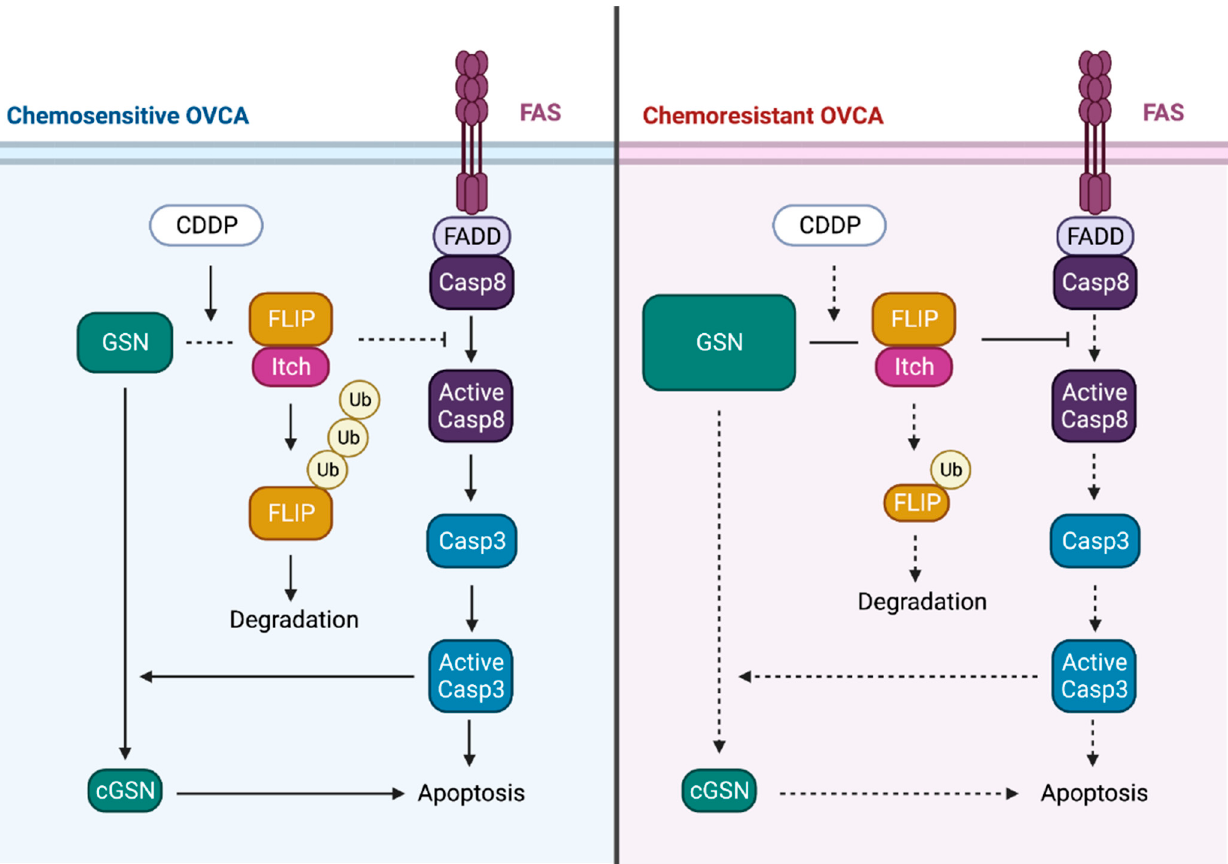
Figure 3. Apoptosis Regulation by pGSN. FLIP and ITCH form a complex with GSN in the chemosensitive OVCA cell. CDDP dissociates GSN from the GSN-FLIP-ITCH complex, leading to FLIP ubiquitination and degradation, caspase-8 and -3 activation, caspase-3-mediated GSN cleavage, and apoptosis. In chemo-resistant OVCA cells, CDDP does not alter the GSN-FLIP-ITCH interaction, attenuating its downstream effects. FLIP, Fas-associated death domain-like interleukin-1b-converting enzyme-like inhibitory protein; ITCH, Itchy E3 ubiquitin protein ligase; Ub, ubiquitin; GSN, gelsolin; CDDP, cis-Diamminedichloroplatinum; FADD, Fas associated via death domain; Casp8, caspase8. (Figure modified from Abedini et al., 2014 [69]. Figure designed using BioRender.